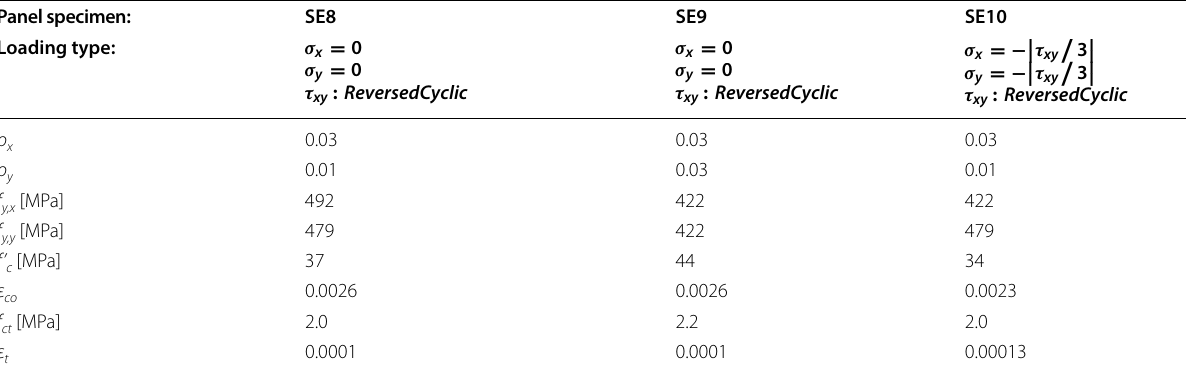
Table 1 Panel test parameters, Stevens (1987). Panel